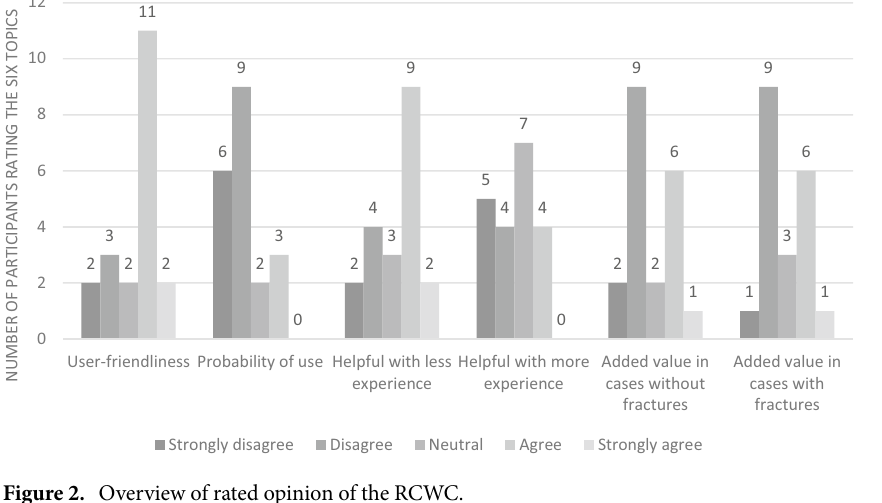
Figure 2. Overview of rated opinion of the